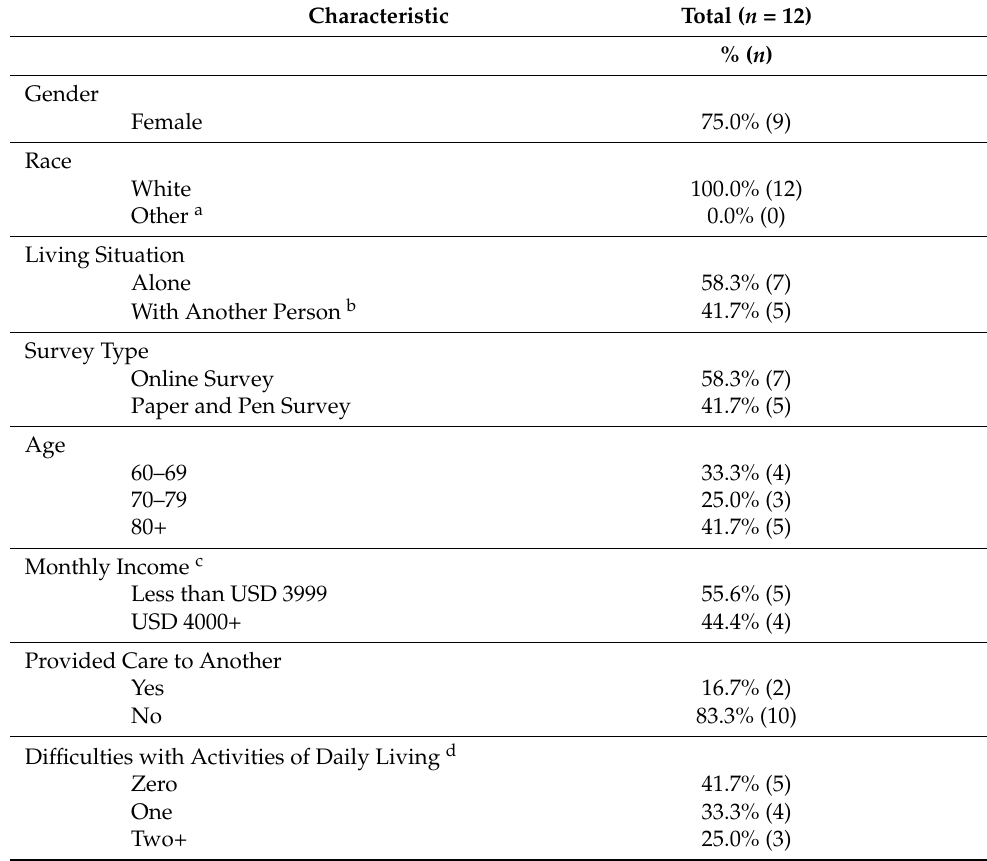
Table 4. Interviewee demographic